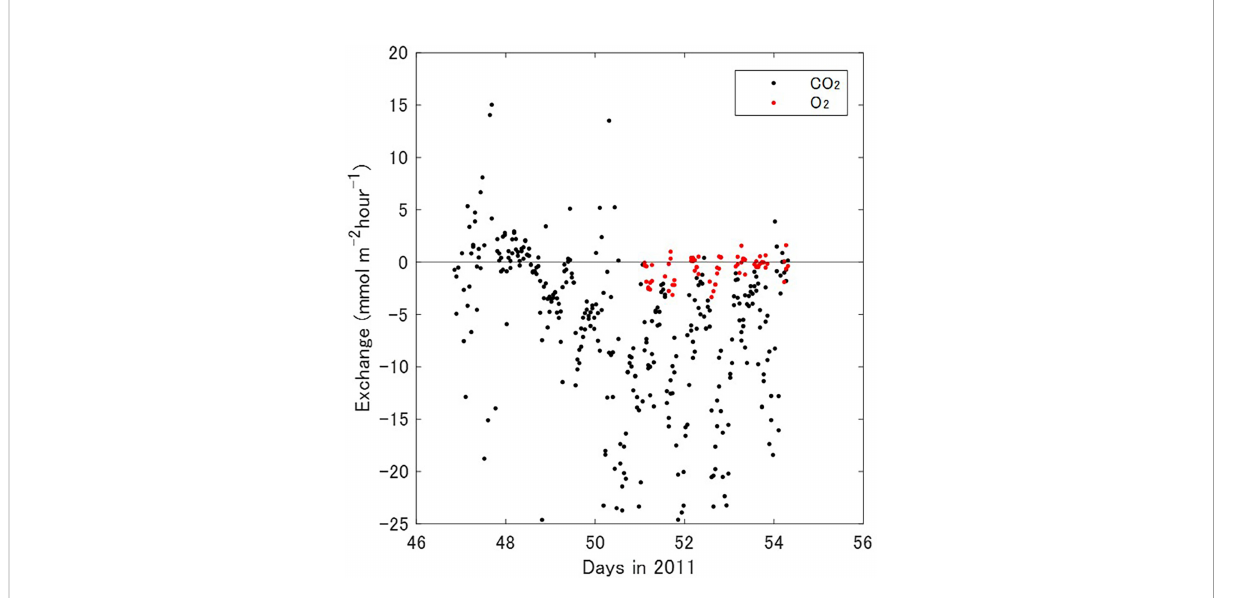
FIGURE 3 Temporal variations of atmospheric CO 2 (black) and O 2 (red) exchange rates measured by EC